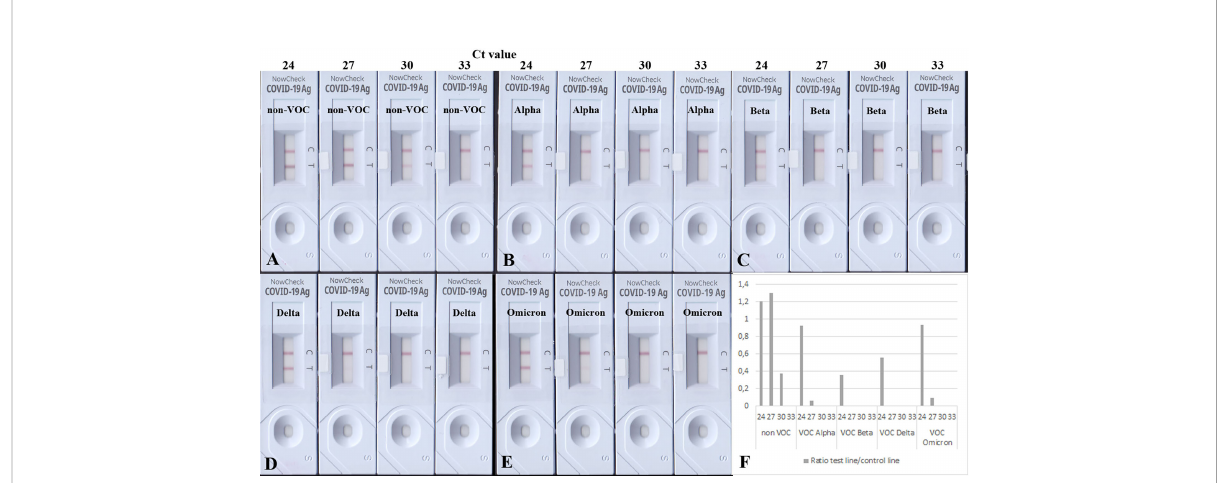
FIGURE 1 BioNote RATs loaded with samples of heat-inactivated cell culture supernatants. (A) non-VOC, (B) Alpha, (C) Beta, (D) Delta, (E) Omicron. (F) Densitometric analysis of VOCs shown on (A – E) . Supernatants were adjusted to comparable viral loads represented by Ct values. All viruses are detected in samples with the highest viral loads but VOCs with less sensitivity (1-2 logs). Densitometric analysis shows comparable detection of VOCs Alpha and Omicron. At Ct = 30, only the non-VOC strain is